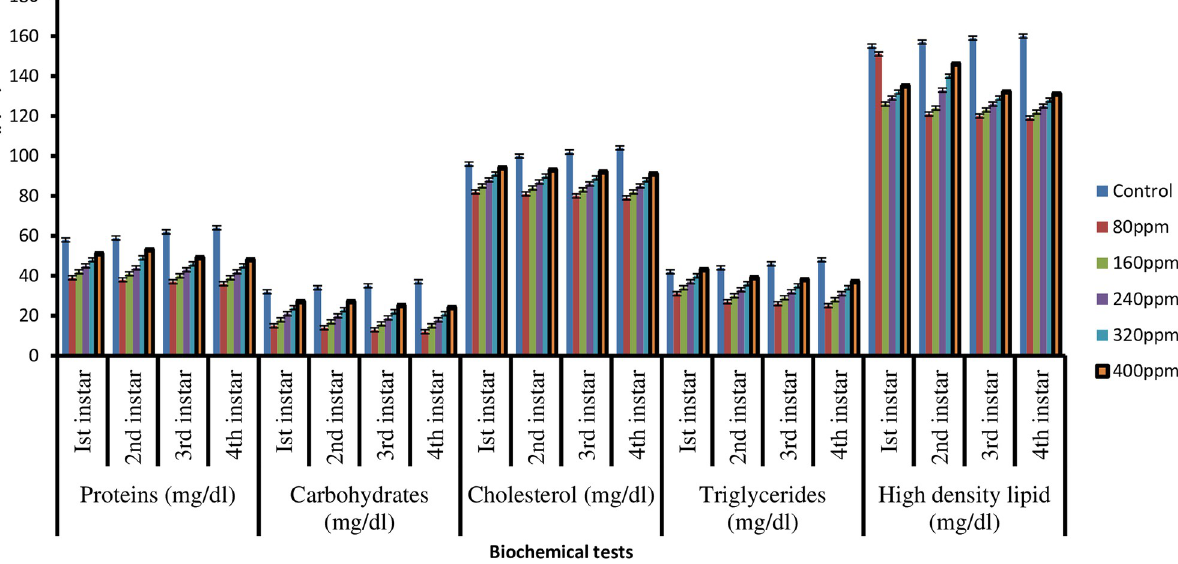
Fig 3. Proteins, carbohydrates, cholesterol, triglycerides and high density lipid estimation of I st , 2 nd , 3 rd , and 4 th instars larvae of C . quinquefasciatus in different concentrations of M . piperita leaves extract in ethanol